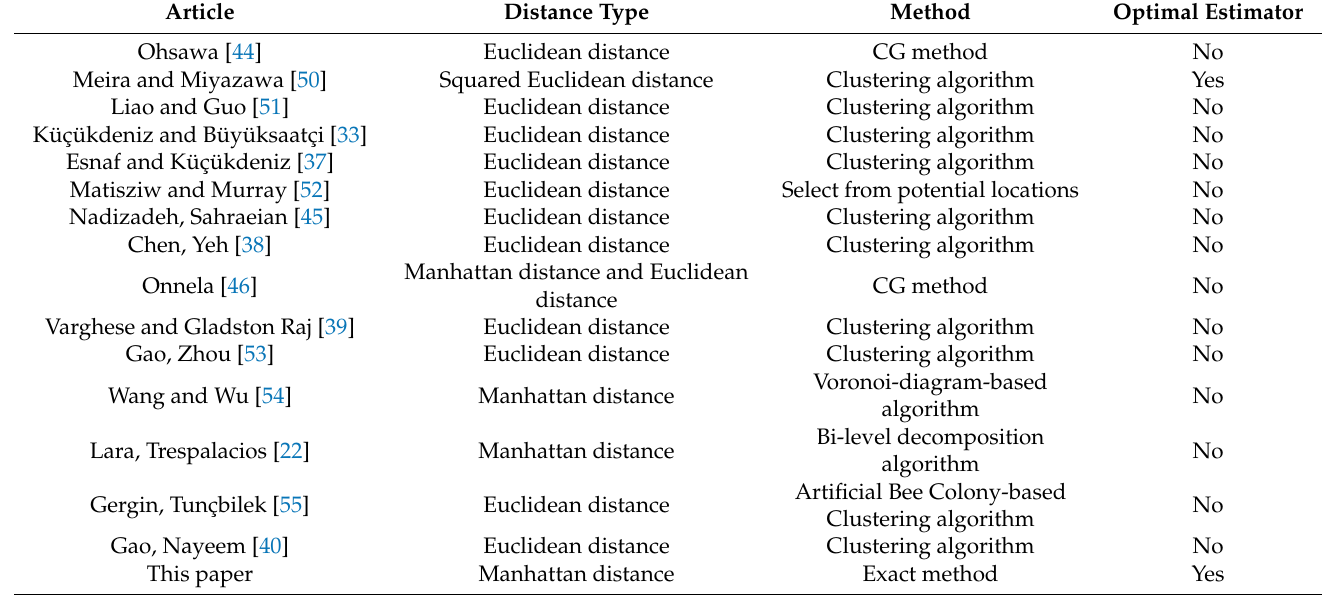
Table 1. Summary of the literature about the continuous-space location